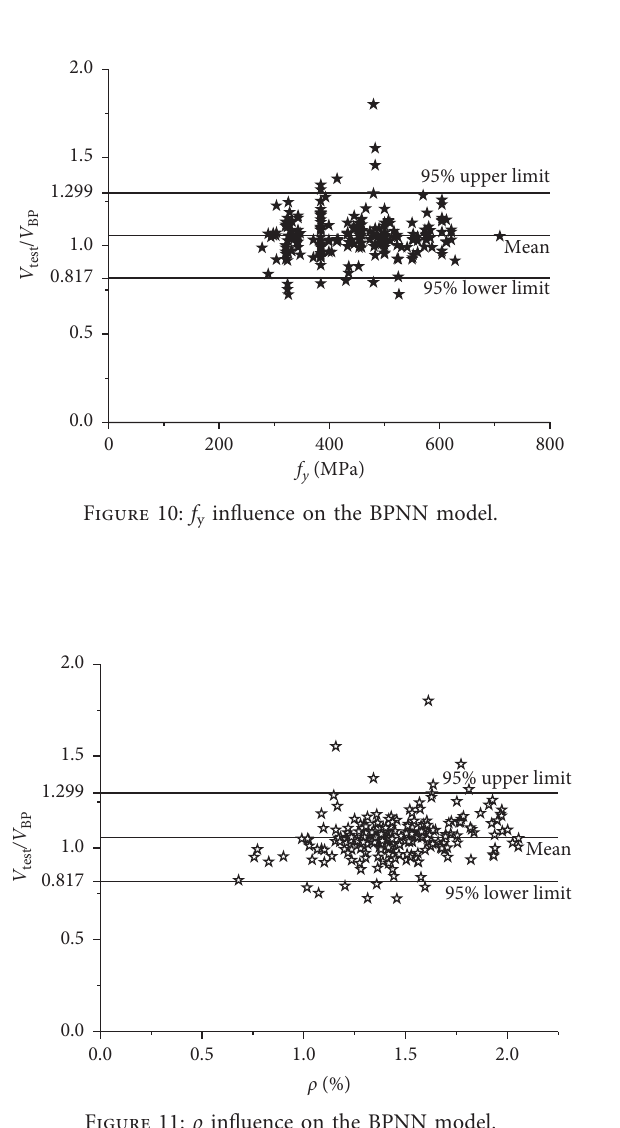
Figure 14: ( L − c ) /2 h influence on ACI 1 0